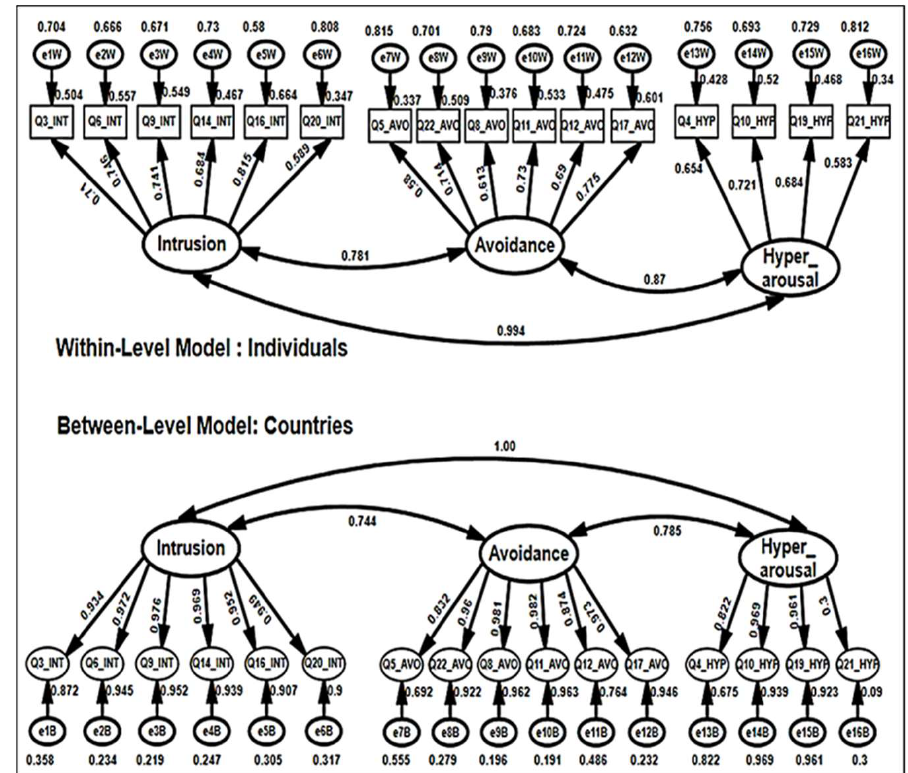
Figure 3. Multilevel confirmatory factor analysis for Impact of Event Scale-Revised. Intrusion (Int.), Avoidance (Avo.), and Hyperarousal (Hyp.).